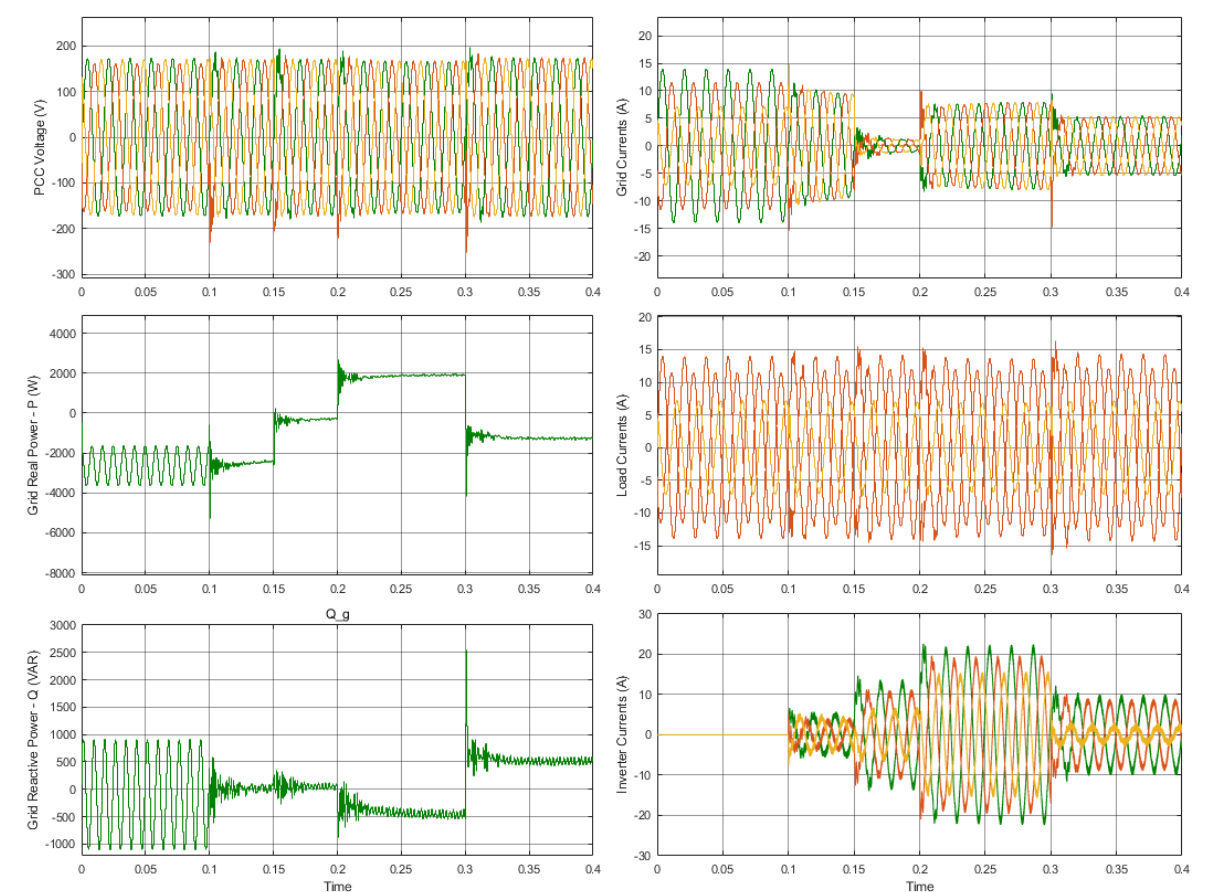
Figure 10. Simulation results under unbalanced grid